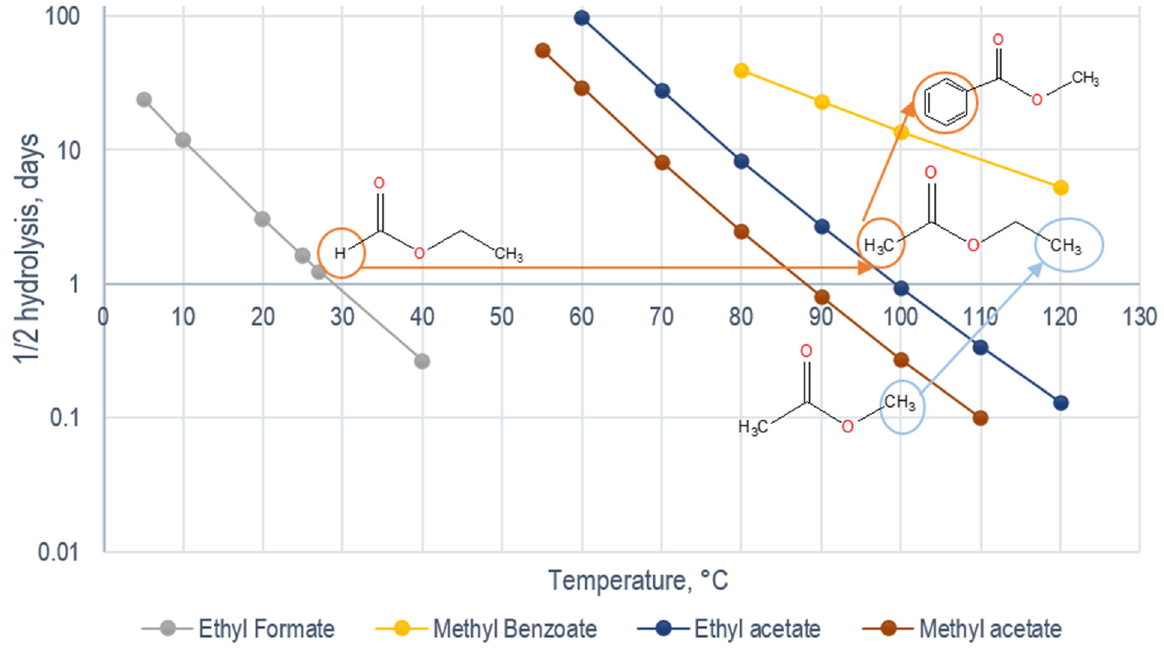
Figure 2. One-half hydrolysis (neutral) of esters at various temperatures (log scale).